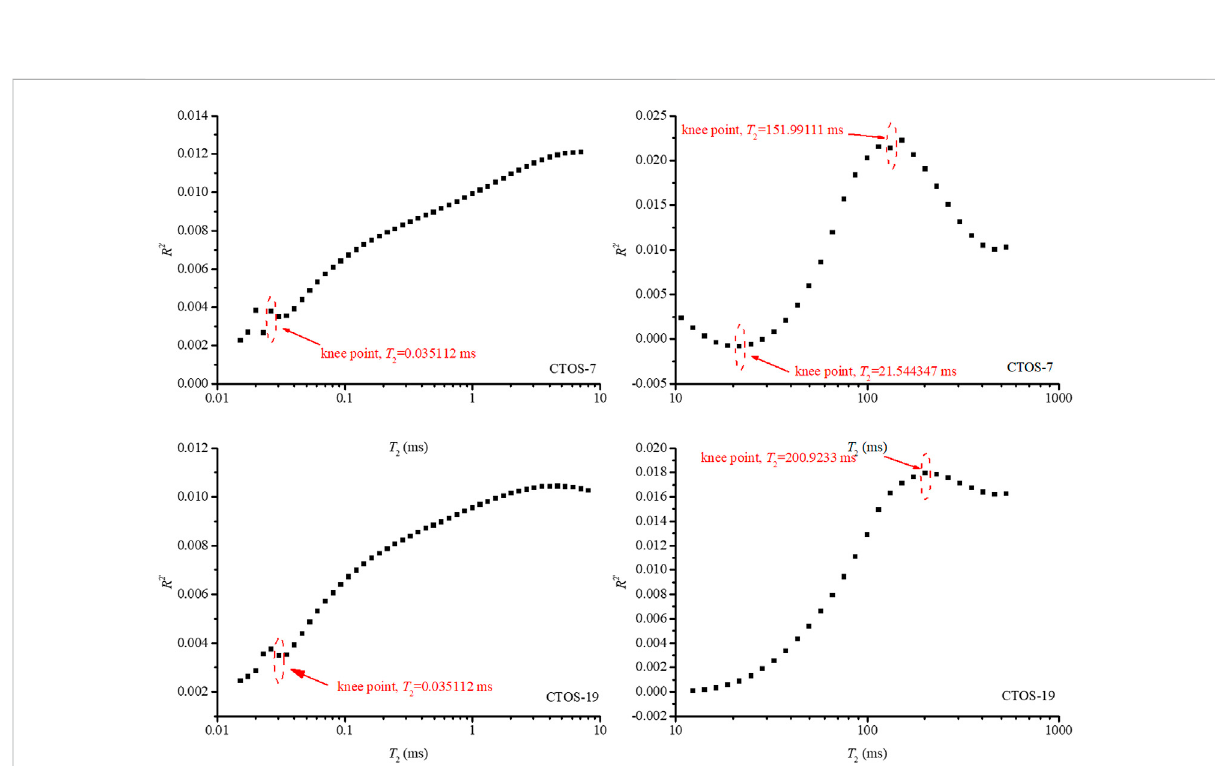
FIGURE 6 The secondary pore classi fi cation of CTOS-7 and CTOS-19 samples.